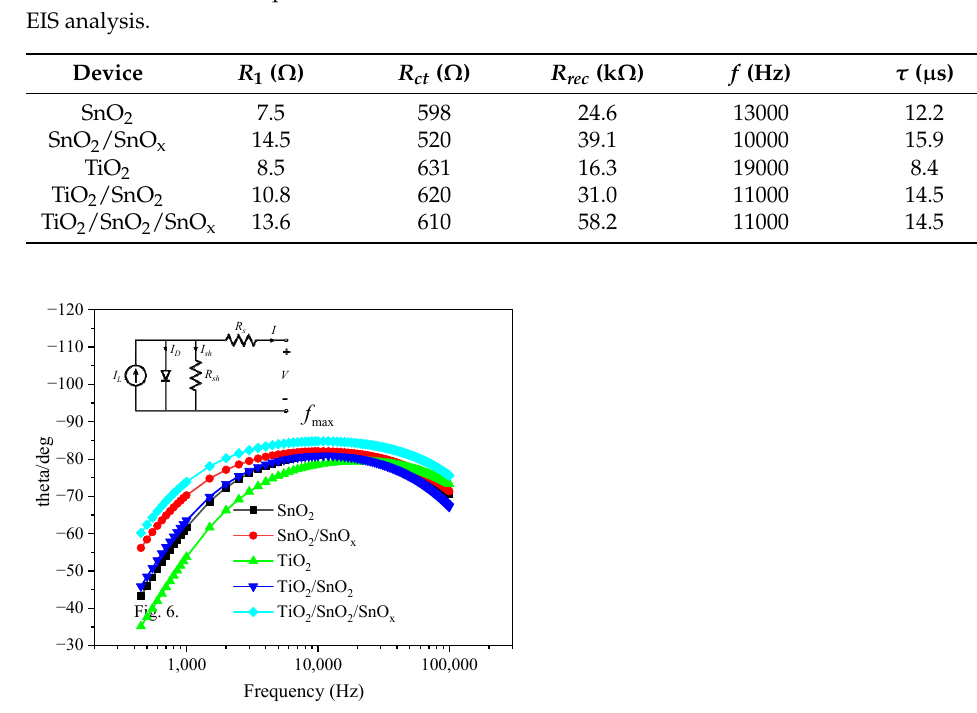
Figure 6. Bode phase plots of PSCs fabricated with the different conditions of ETL in dark condition and an equivalent circuit of solar cell in the inset. Table 3. Electrochemical parameters fabricated with the different conditions of ETL calculated from EIS analysis.